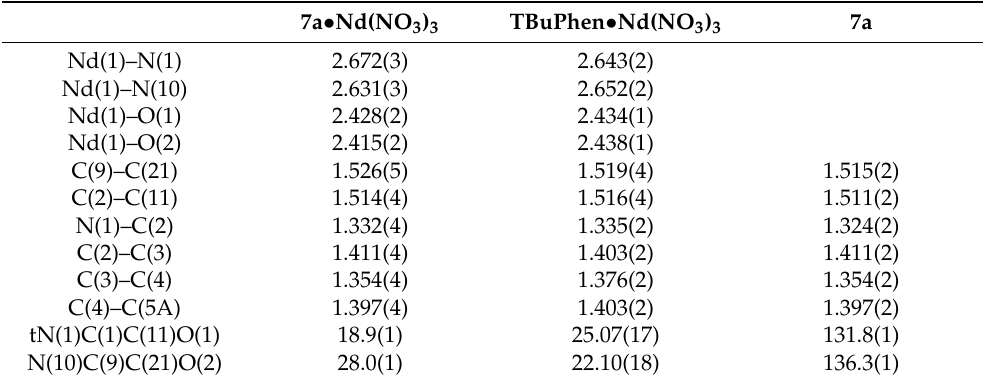
Table 4. Selected bond lengths and angles for Nd complex with 7a and TBuPhen ligands.